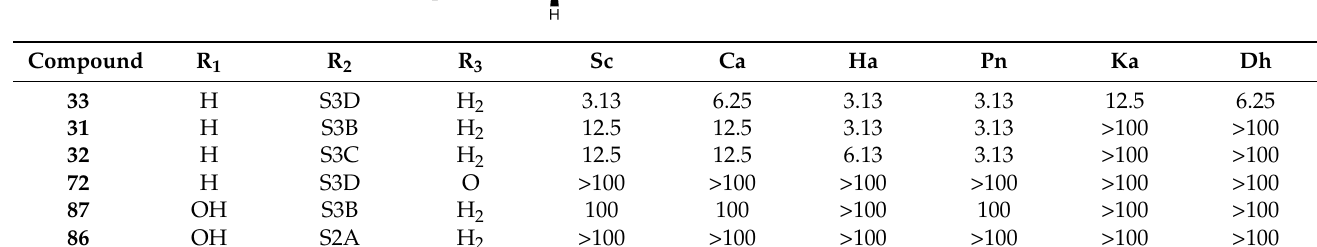
Table 5. MIC ( μ M) values calculated for the individual saponins from Y. schidigera [14]. Table 5. MIC ( µ M) values calculated for the individual saponins from Y. schidigera [14].